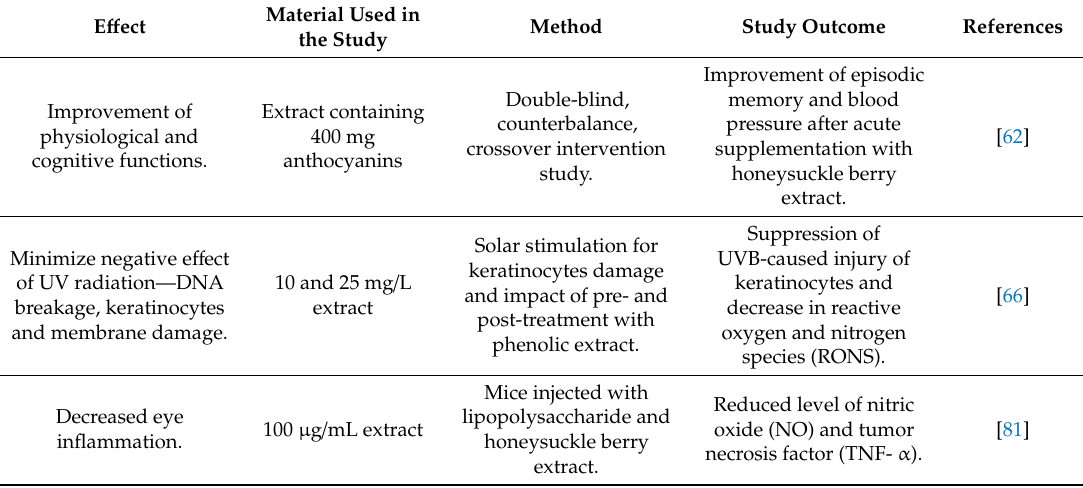
Table 2. Health-associated e ff ects of honeysuckle berries based on in vitro and in vivo tests. E ff